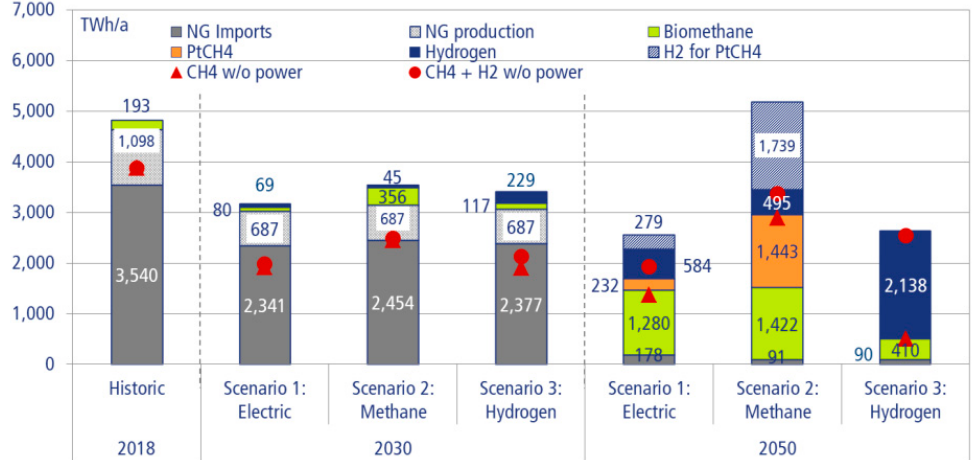
Figure 13. Gas supply in the EU 28 for 2030 and 2050, European Commission [96].